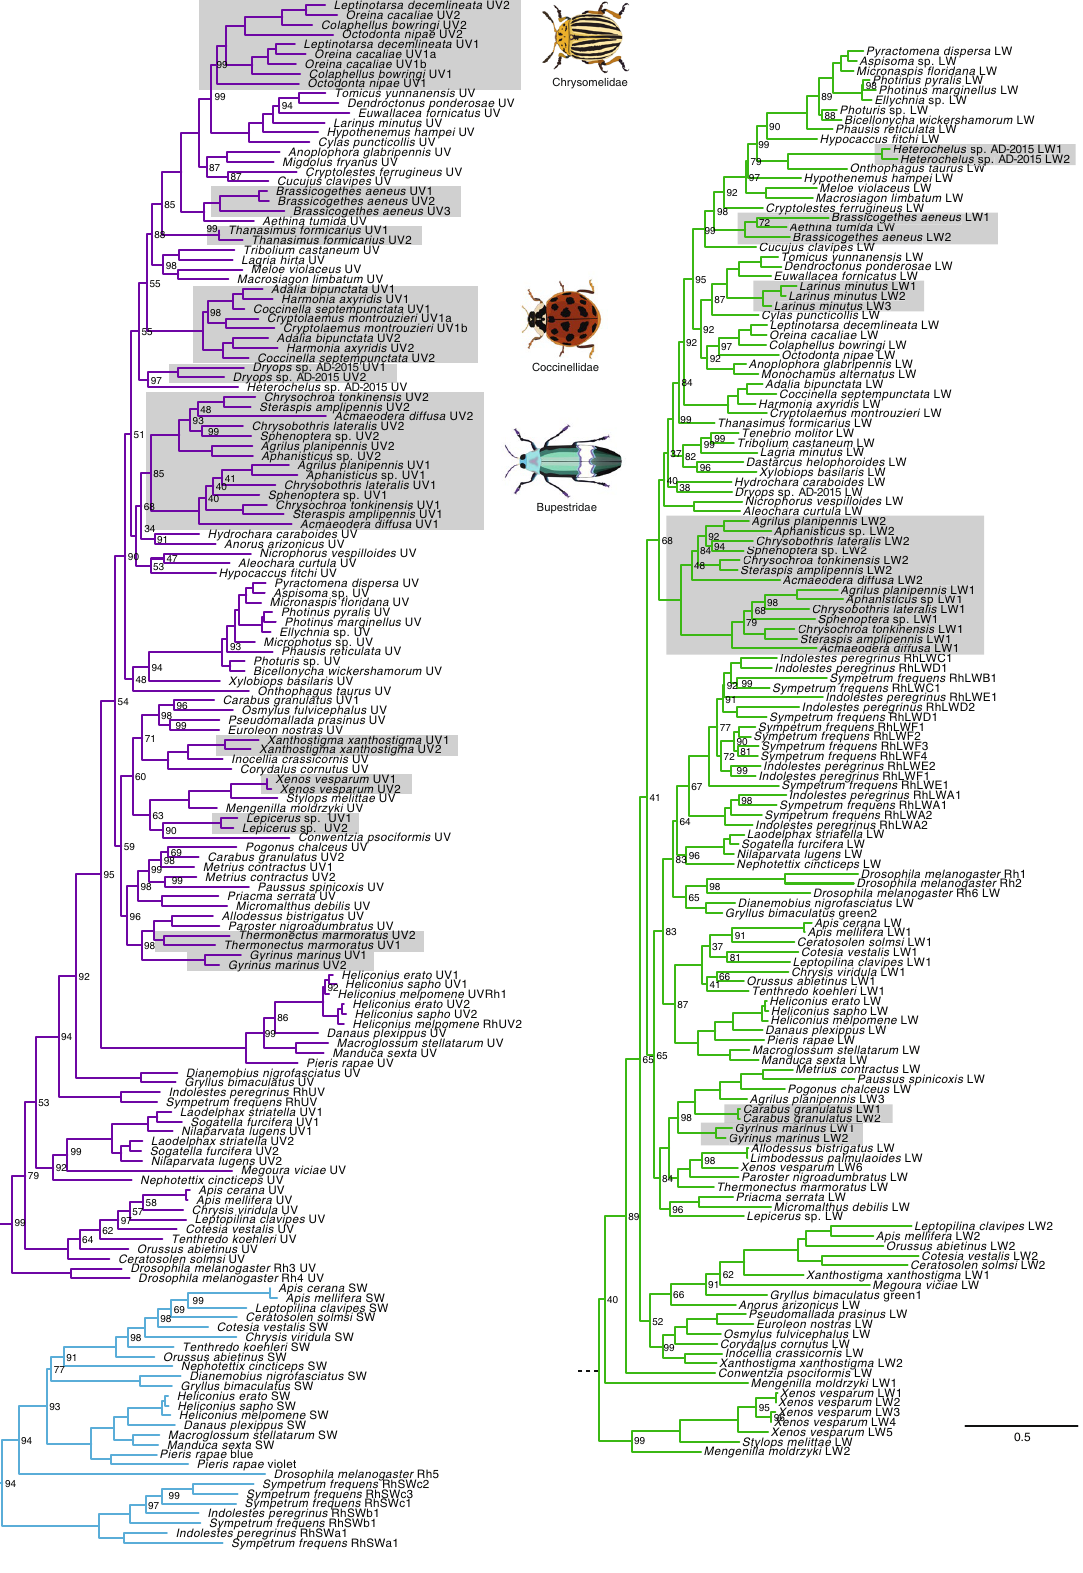
Figure 2. Beetle opsin gene phylogeny. Maximum likelihood DNA phylogeny of all visual opsin genes from this study and other insect UV (purple), SW (blue) and LW (green) opsins rooted to cephalopod opsins (not shown). Node values (UFBoot support values) are based on 10,000 replicates. Values of 100 are not shown. Duplicated neuropteroid opsins are highlighted in